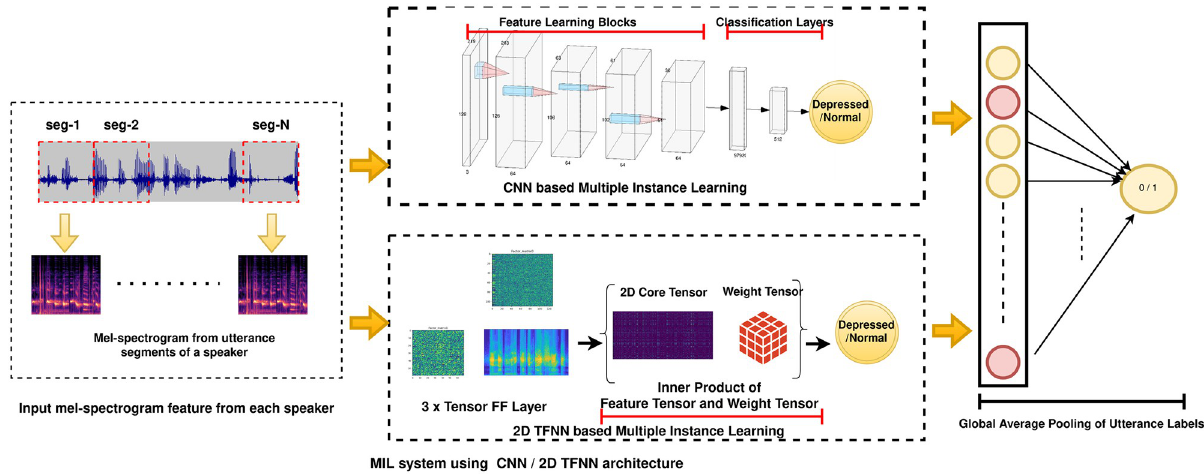
Fig 1. MIL technique using CNN (top) and TFNN (bottom) as base architectures. The input to the architectures is 2D Mel-spectrogram tensor, generated from speech utterances of a speaker. For the CNN architecture, stacks of three feature learning blocks followed by vectorization and dense layers is depicted. For TFNN, stacks of three 2-D Tensor FF layer followed by a Tensor Sigmoid layer is depicted. Finally, global average pooling of utterance labels is shown.